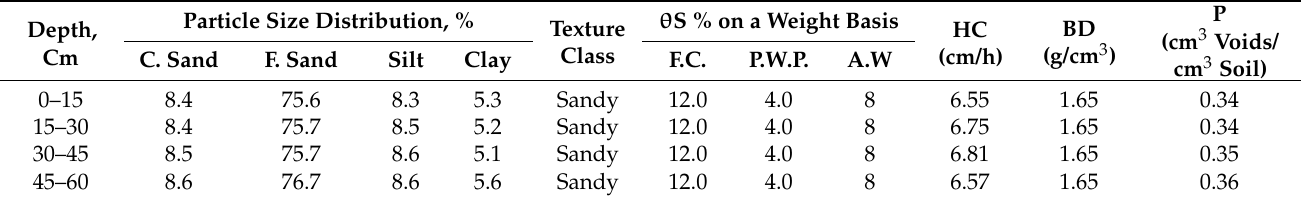
Table 2. Some physical properties of soil in the experimental